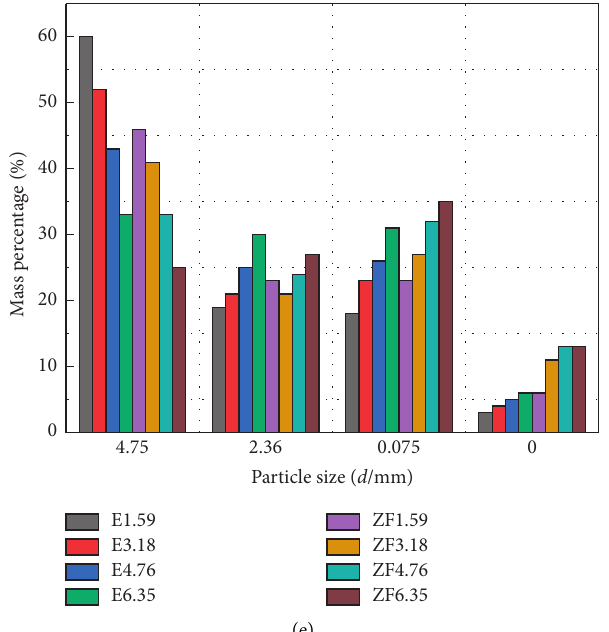
Figure 10: Weight percentage of crushed granule under different impact loads. (a) 26.5–31.5mm mass percentage. (b) 19–26.5 mm mass percentage. (c) 16–19mm mass percentage. (d) 9.5–16mm mass percentage. (e) 4.75–9.5 mm mass